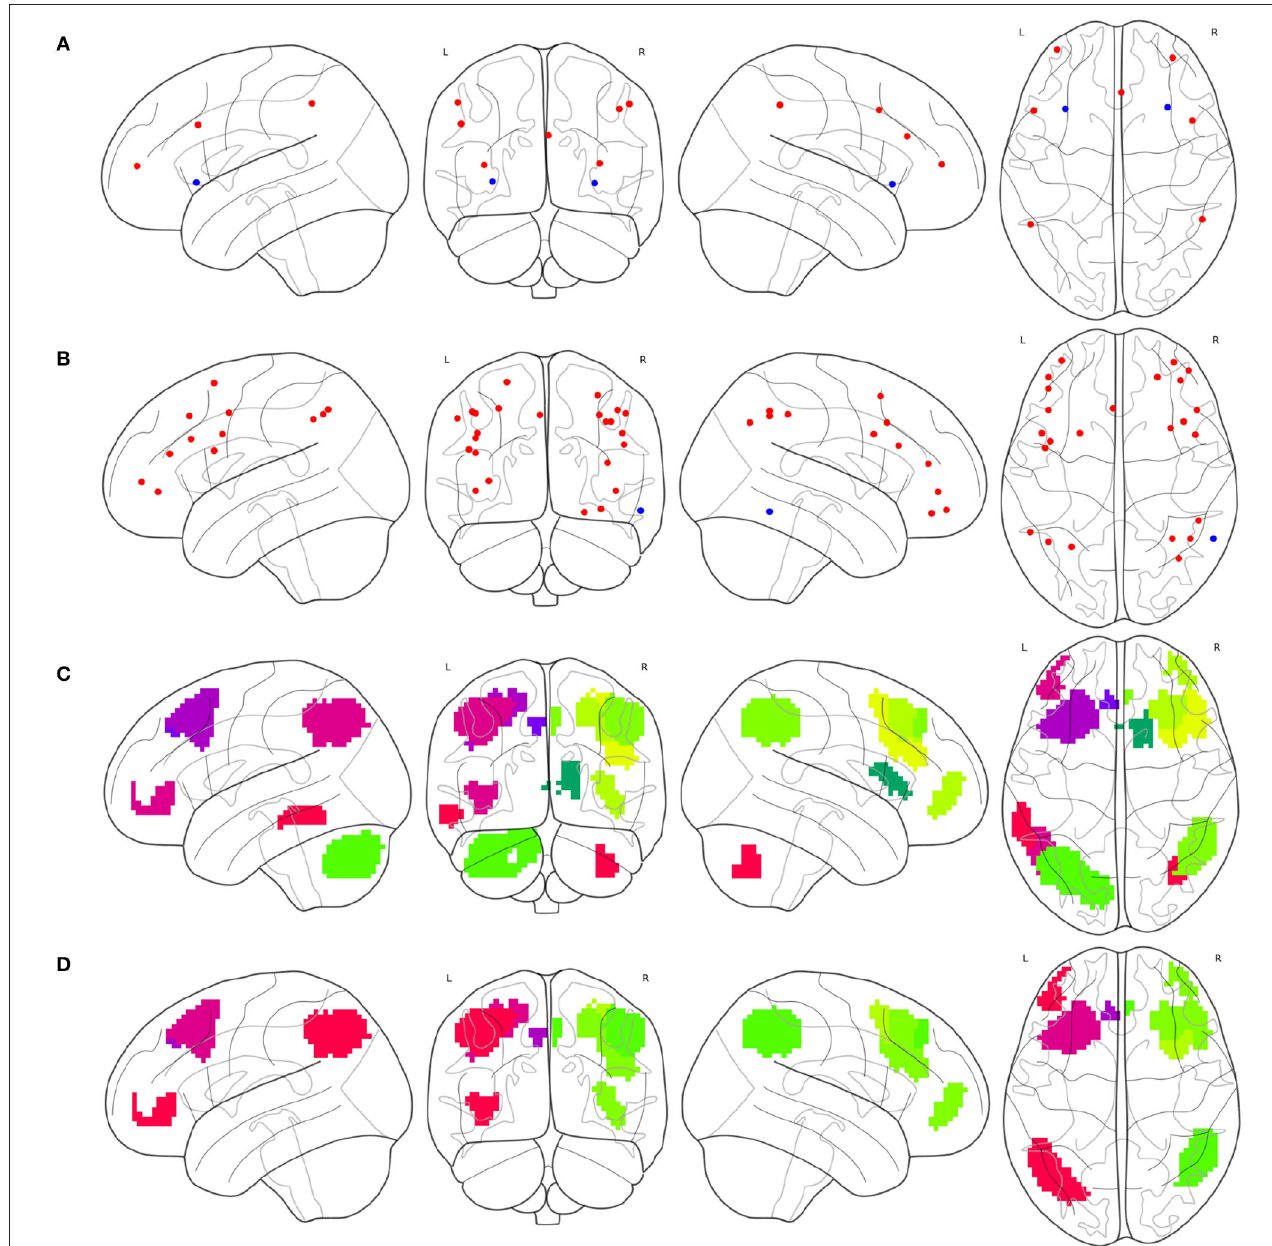
FIGURE 2 | Definition issues of the FPNs in some brain atlases, (A) the ROIs in the FPN of Gao-32, where the blue ROIs belong to the insula, (B) the ROIs in the FPN of Power-264, where the only blue ROI belongs to the temporal lobe, (C) the regions in the ECN of Willard-499, where some of the regions belong to limbic lobe, temporal lobe, or cerebellum, and (D) the frontal and parietal regions in the ECN of Willard-499.